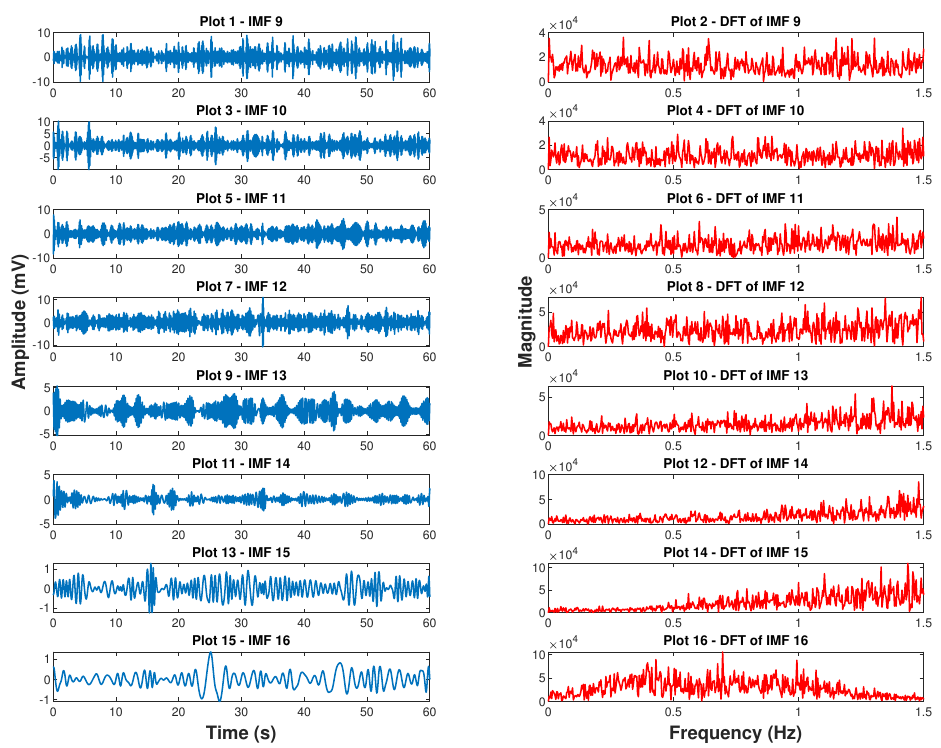
Figure 3. DFT analysis of the IMFs 9 to 16 of b001: The plots on the left column depict IMFs 9 to 16. The plots on the right column show the corresponding spectra (DFT points = 300,000).